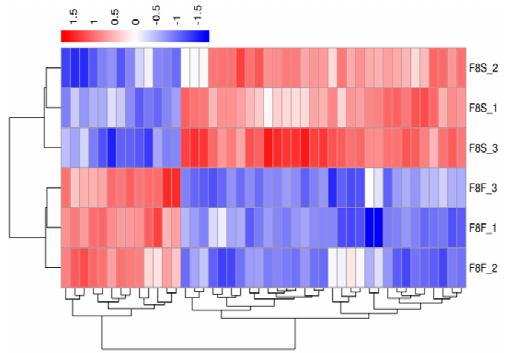
Figure 5. Overall FPKM hierarchical clustering map of the eight-week-old males.